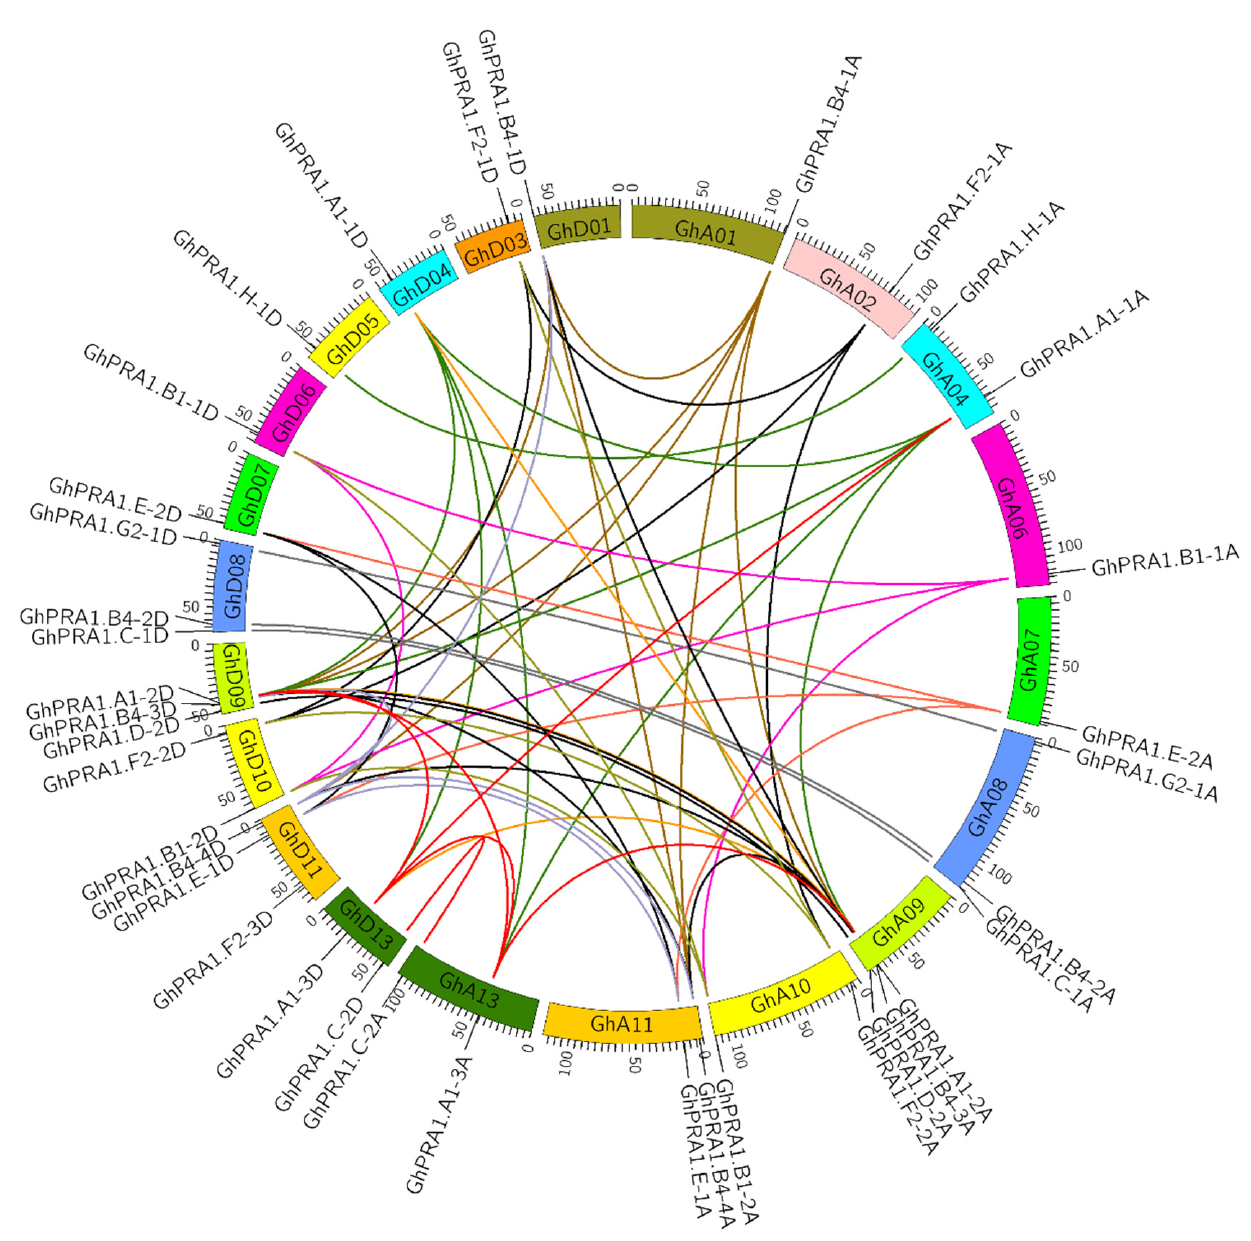
Figure 4. Syntenic relationships of GhPRA1 genes in upland cotton. Homologous chromosomes in the At and Dt subgenomes are displayed in the same color. The brown lines represent repetitive genes of GhPRA1.B4-1A/D ; dark blue lines represent repetitive genes of GhPRA1.F2-1A/D ; the green lines indicate repetitive genes of GhPRA1.A1-1A/D and homologous genes of GhPRA1.H-1A ; the purple line indicates a repetitive gene of GhPRA1.A1-1A/D ; the pink line indicates a repetitive gene of GhPRA1.E-2A ; the gray line indicates a homologous gene of GhPRA1.G2-1A Magi GhPRA1.C-1A; the orange line represents a repetitive gene of GhPRA1.A1-2A/D; the black line represents a repetitive gene of GhPRA1.B4-3A/D; and the light brown line represents a repetitive gene of GhPRA1.C-1A . With respect to the repetitive genes in GhPRA1.B1-2A and GhPRA1.F2-2A , the light purple line indicates a repetitive gene of GhPRA1.B4-4A 3A/D , and the red line indicates a repetitive gene of GhPRA1.A1-3A/D and the homologous gene in GhPRA1.E-3A . Duplicated GhPRA1 genes were analyzed in this study. We observed that